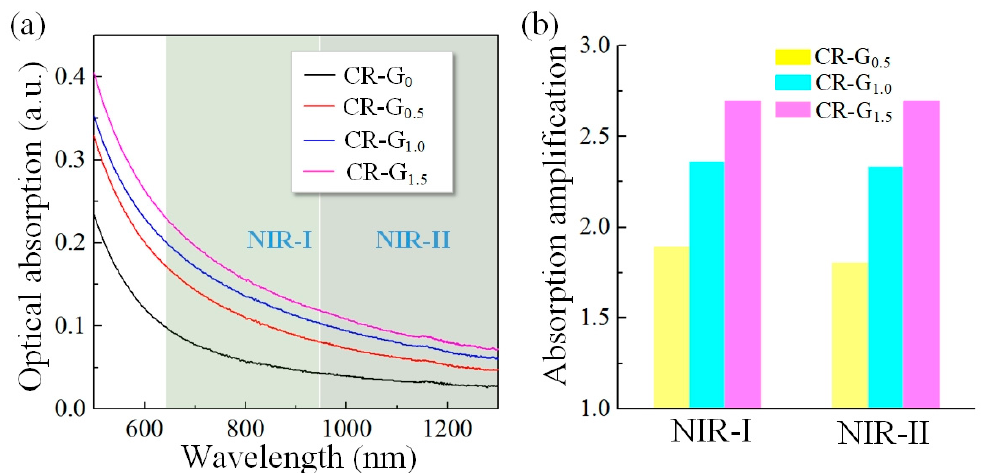
Figure 3. Optical characterization of the chemically-reduced graphene oxide (CR-G). ( a ) The meas- ured optical absorption spectra of CR-G nanomaterials with different degrees of reduction in the near infrared (NIR)-I and NIR-II biowindows. ( b ) Quantitative analysis of the optical absorption enhancement by chemical reduction for the CR-G nanomaterials with different degrees of reduction in both NIR-I and NIR-II biowindows.